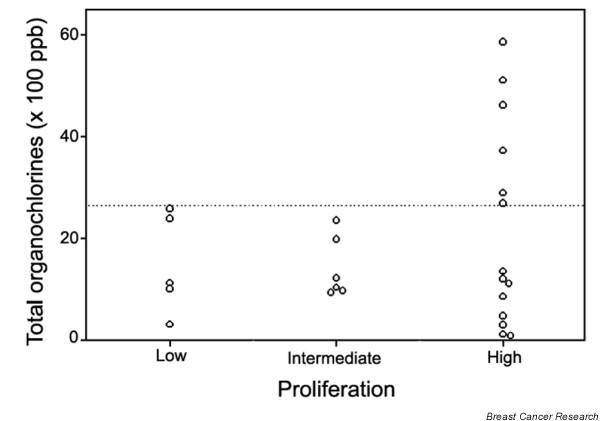
High organochlorine levels promote high proliferation in estrogen receptor-α positive breast carcinomas of postmenopausal. All ERα-positive breast carcinomas from postmenopausal women had high cellular proliferation when levels of organochlorine residues were 2600 ppb or higher (above the dashed line) (Fisher's exact test, P = 0.017 – statistical analysis of tumors with low and intermediate proliferation grouped).